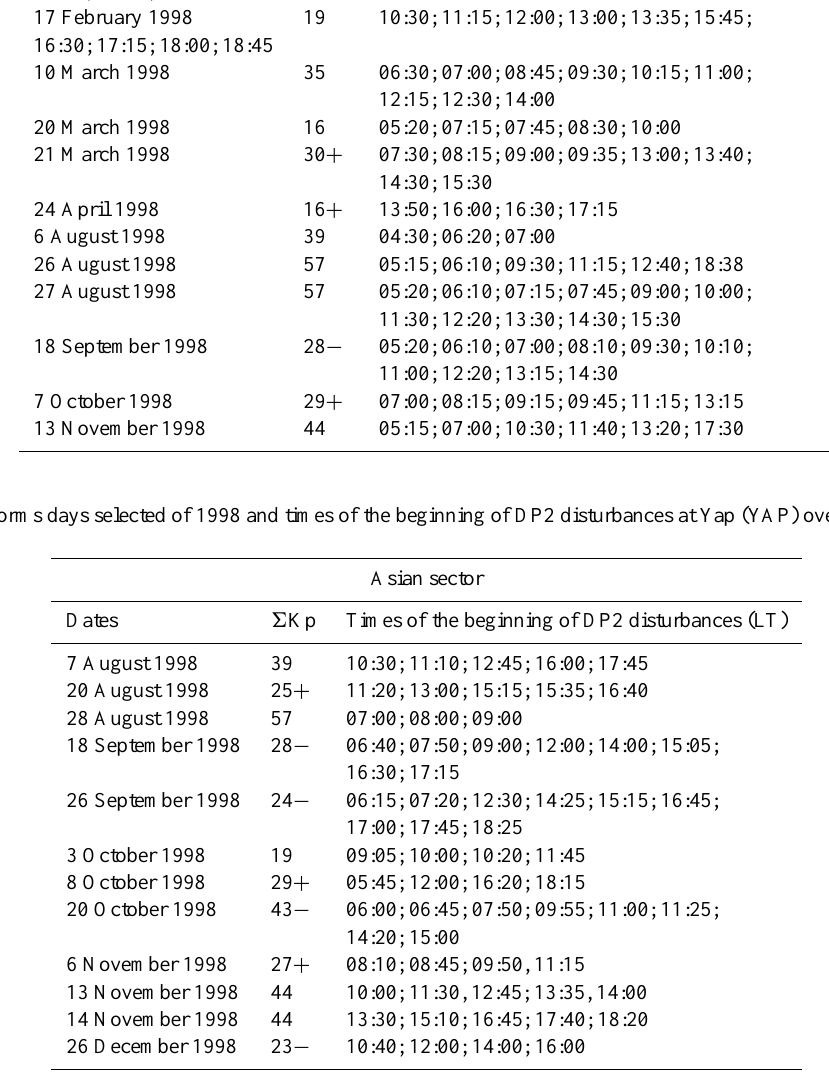
Table 3b. Magnetic storms days selected of 1998 and times of the beginning of DP2 disturbances at Huancayo (HUA) over American sector. American sector